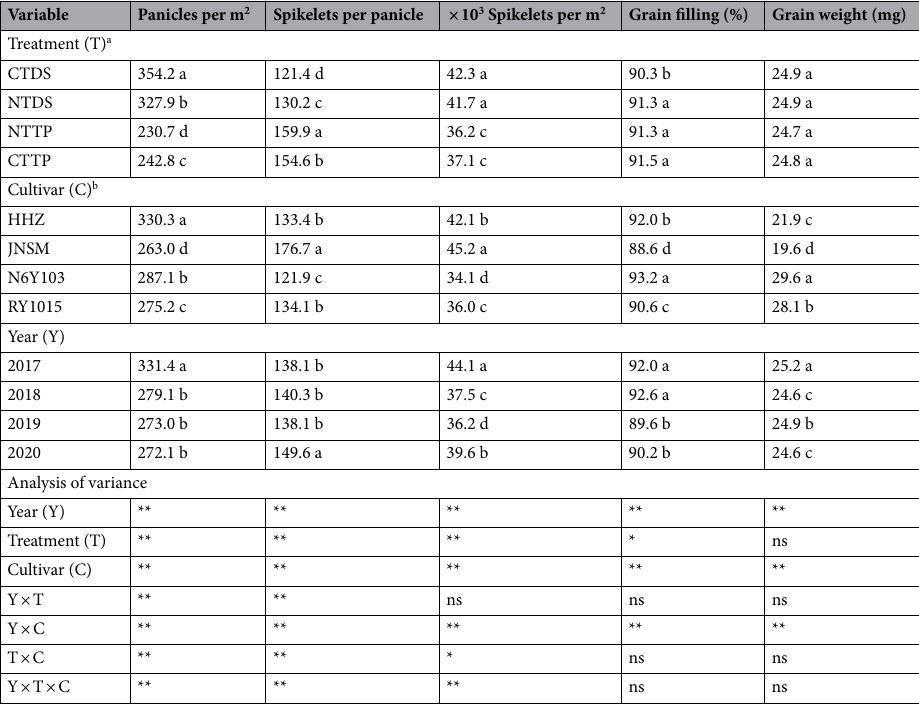
Table 4. Yield components of four rice cultivars grown under four cultivation methods in main crop season in 2017–2020. a CTDS, NTDS, NTTP and CTTP represent conventional tillage and direct seeding, no-tillage and direct seeding, no-tillage and transplanting and conventional tillage and transplanting respectively. b HHZ, JNSM, NY103 and RY015 are Huanghuazhan, Jinnongsimiao, Nei6you103 and Rongyou1015, respectively. Means within each variable sharing the same letter are not significantly different according to LSD at P = 0.05. *Significant at P < 0.05, ** Significant at P < 0.01, ns, not significant at P <